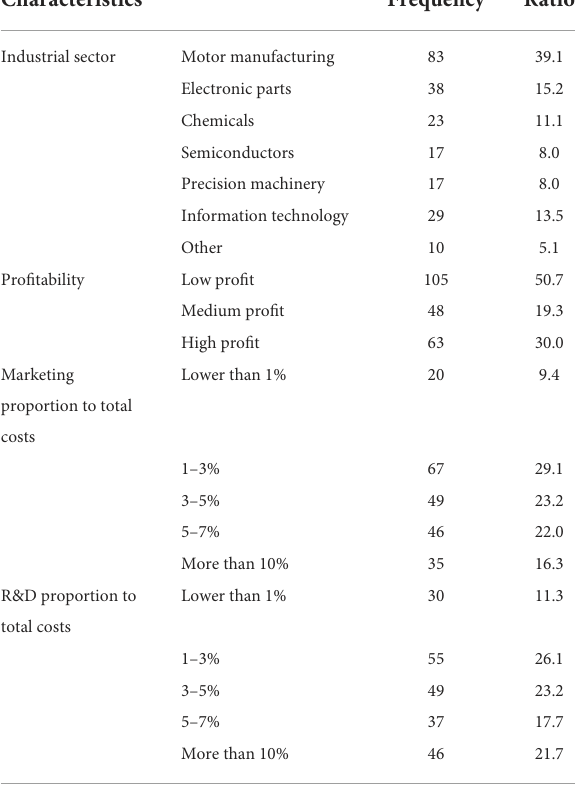
TABLE 1 Demographic characteristics of